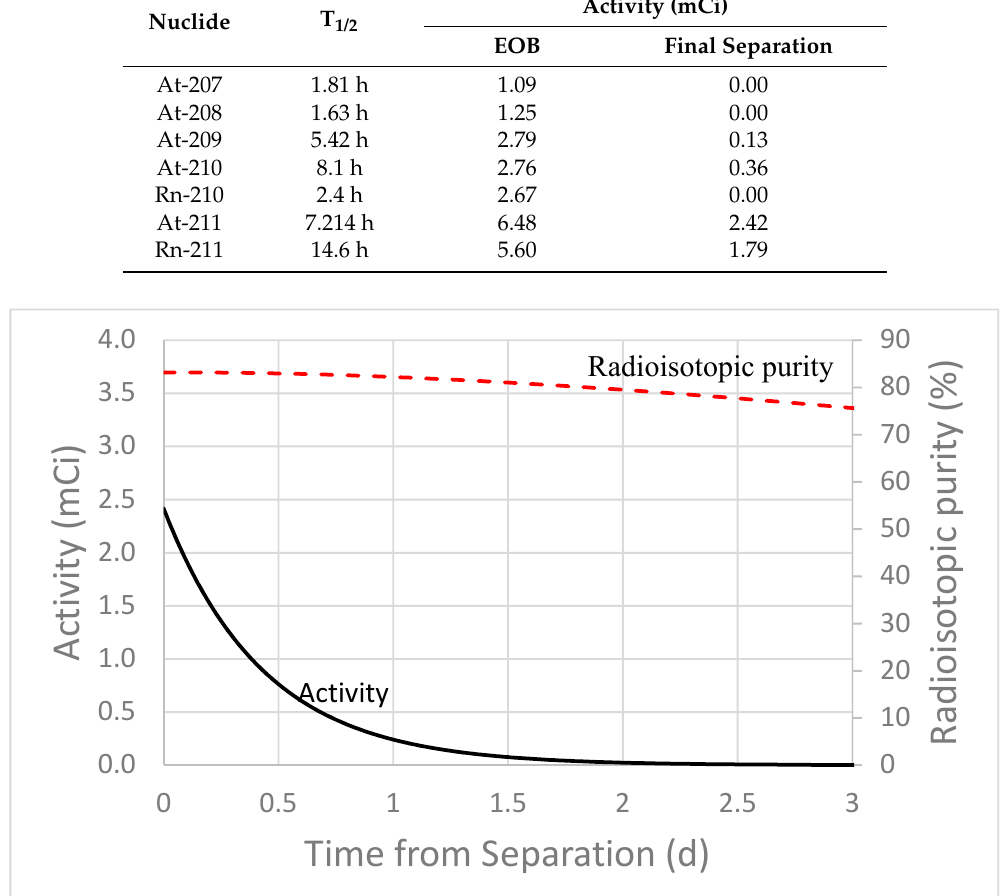
Table 5. Radioactive quantities of various astatine and radon isotopes produced in a proton irradiated thorium target produced at the BLIP. Parameters for calculations: a 1 g Thorium-232 target; proton irradiation at 192 MeV; 150 µA for one day.